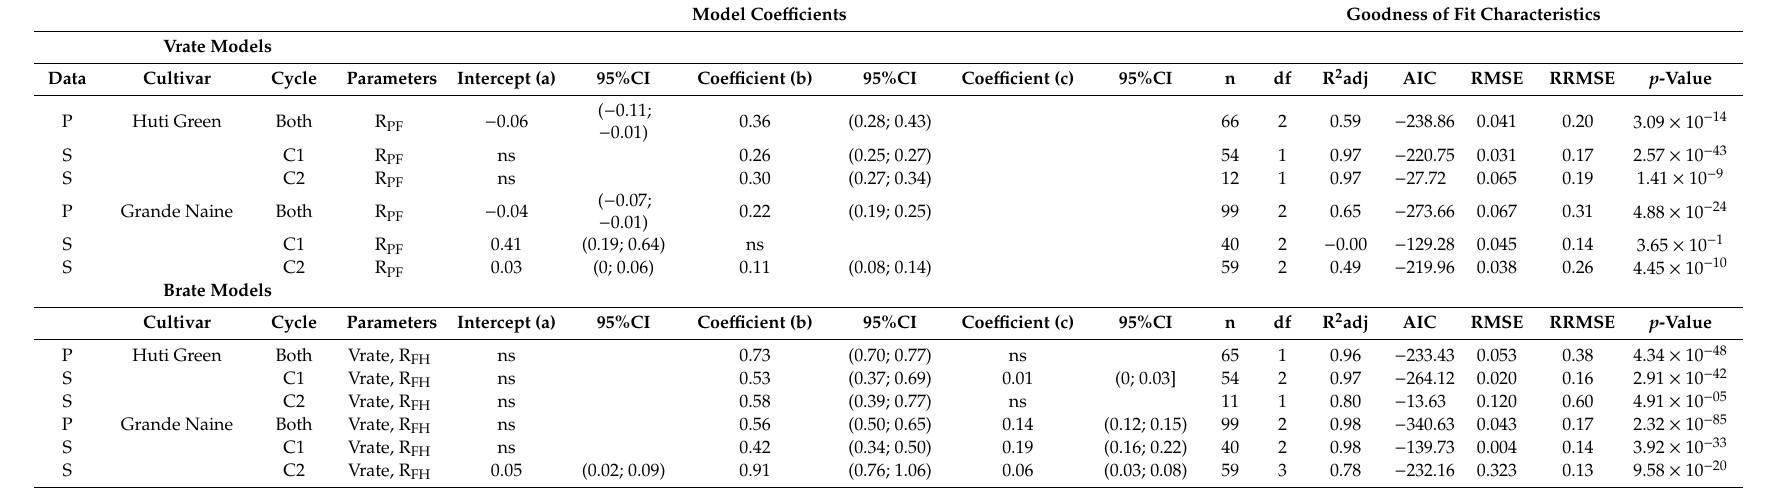
Table 3. Linear regression model output for average pseudostem growth rate until flowering (V rate , L day − 1 ), and average bunch growth rate between flower emergence and harvest (B rate , kg day − 1 ) in terms of added moisture and reference evapotranspiration. Models are characterized by parameter x, intercept ‘a’ and slope ‘b’ and ‘c’ as y = a + b × x + c × y. V rate and B rate models note models with y being V rate and B rate respectively. P indicates pooled model, S indicates specific model. Both indicates pooling of data across cultivars and / or cycles. FI notes full irrigation and RF notes Rainfed. R PF and R FH note ratio of cumulative added moisture (rainfall and precipitation) to cumulative ET0 between planting and flowering, and flowering and harvest